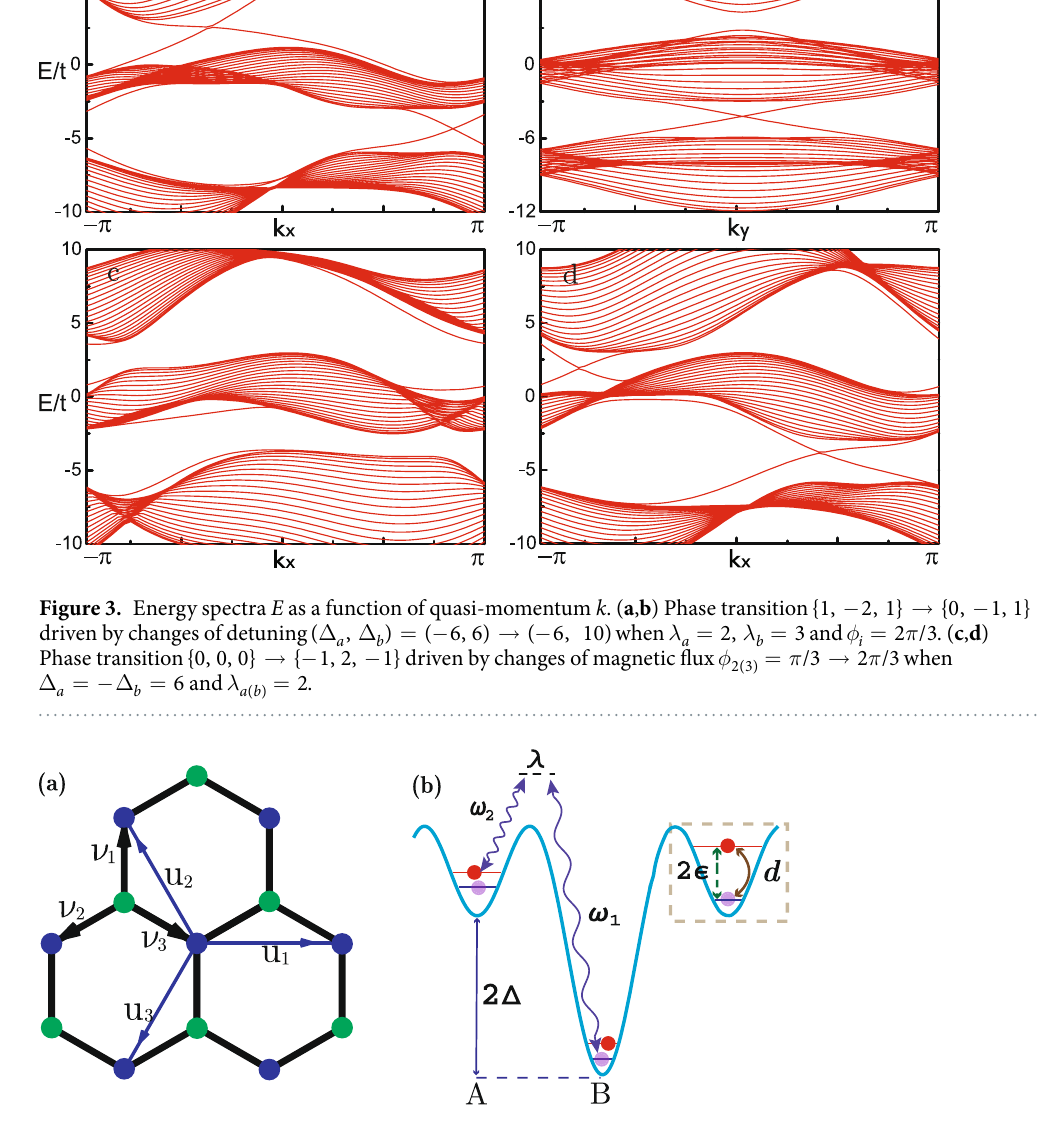
Figure 4. ( a ) Honeycomb optical lattice with NN vectors ν i and NNN vectors u i ( i = 1, 2, 3). ( b ) Atoms of different internal states with energy ± ε , show Rabi oscillation of strength d . NN tunnelling is laser-assisted through two-photon Raman process of strength λ with internal state changed, while the normal NN tunnelling is suppressed by the large potential barrier 2 Δ between the two